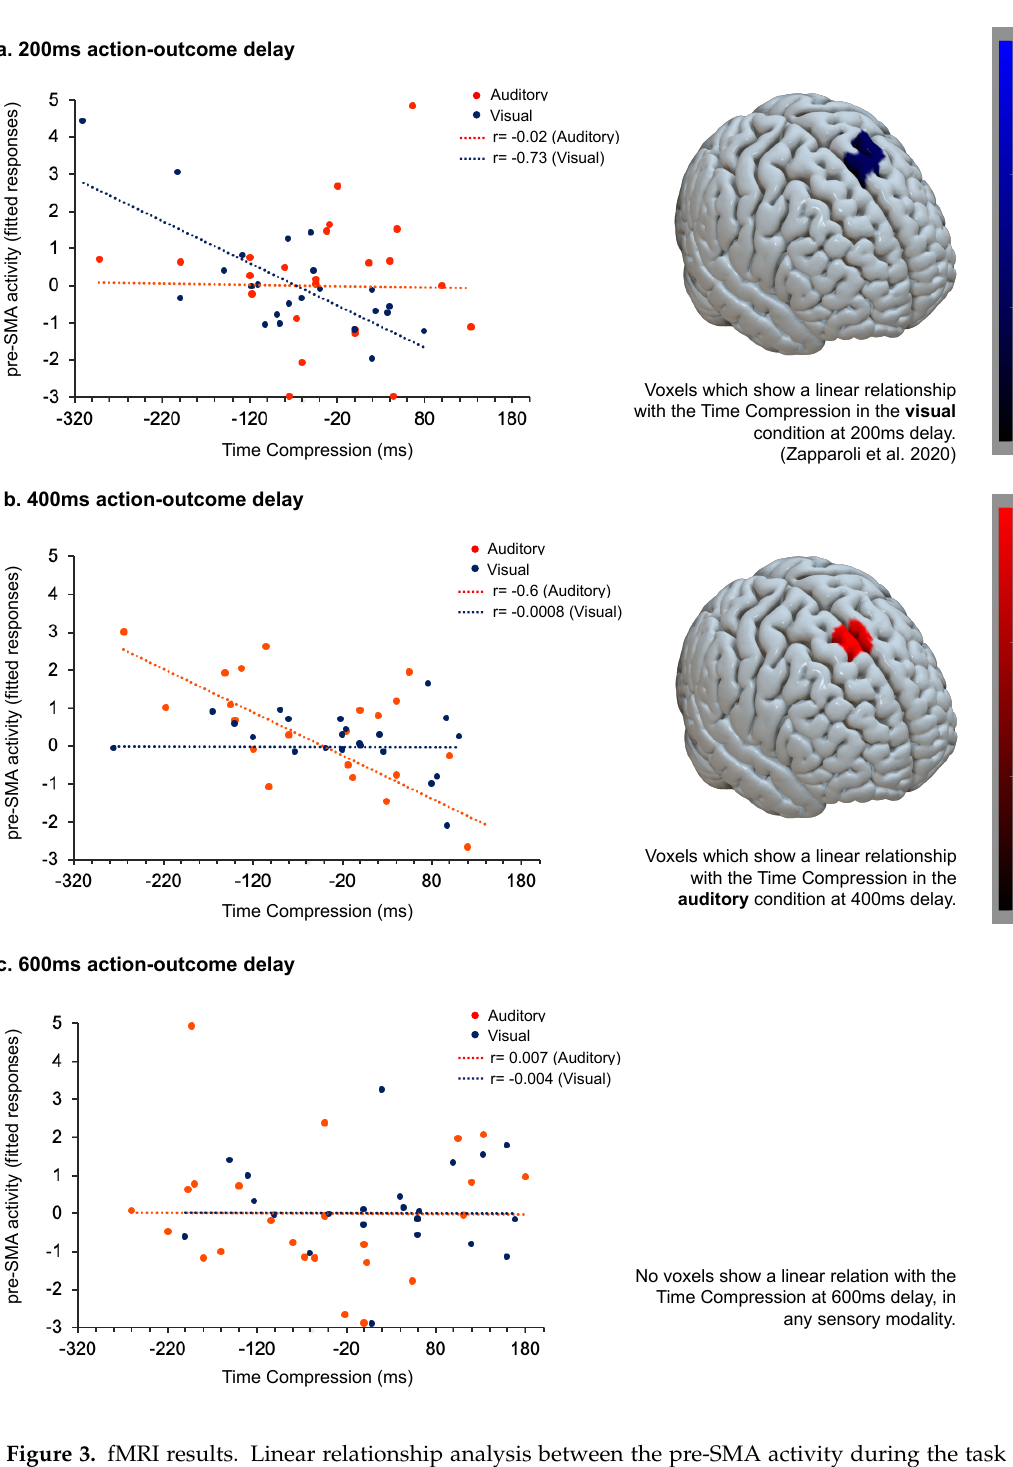
Figure 3. fMRI results. Linear relationship analysis between the pre-SMA activity during the task (fitted responses, active > passive conditions) and the di ff erential TC values (active trials—passive trials) when the action-outcome delay was 200 ms ( a ), 400 ms ( b ) and 600 ms ( c